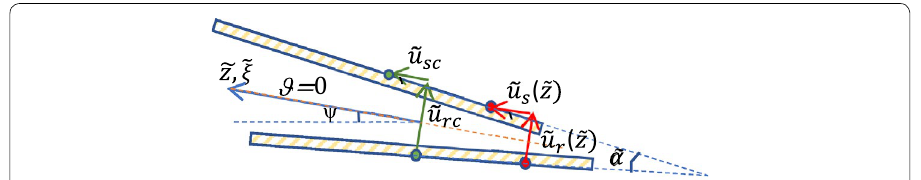
Fig. 2 Crack‑plane relative‑displacements including elastic‑band of